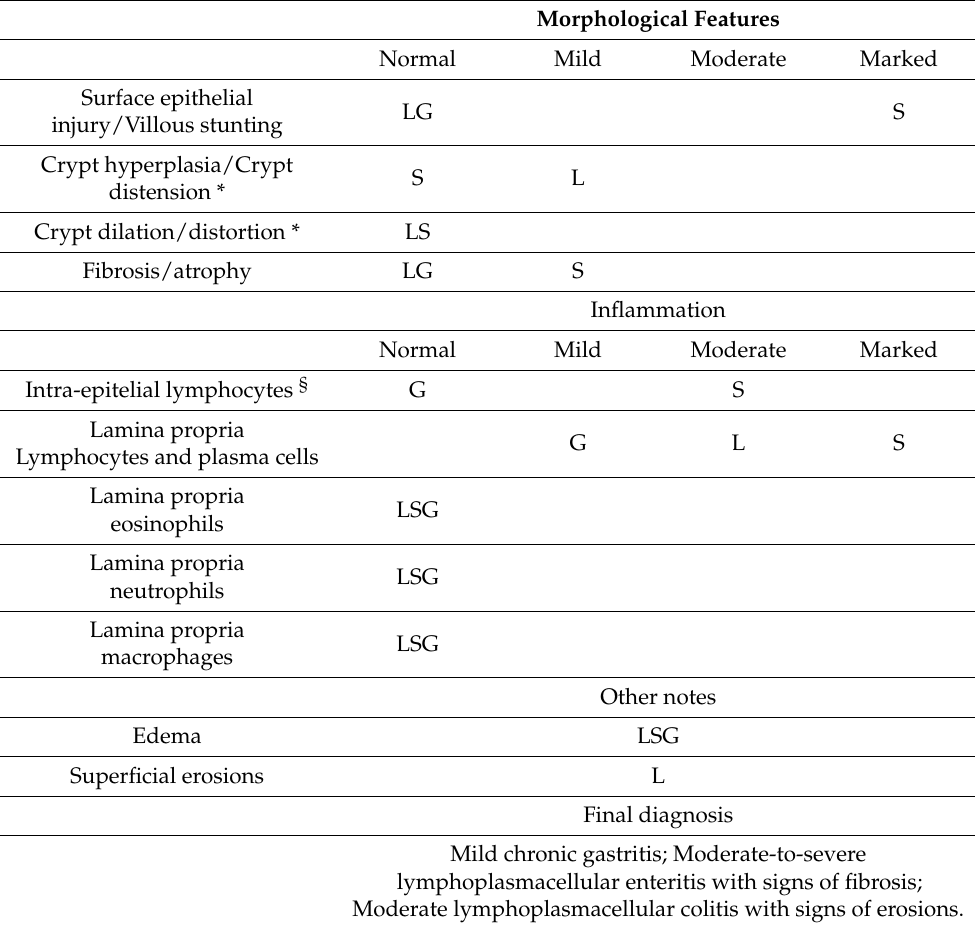
Table 6. Major findings described by the pathologist (L.A.) while assessing biopsies of the puppy duodenal and colonic mucosa. Description has been carried out in accordance with WSAVA Gastroin- testinal Standardization Group guidelines